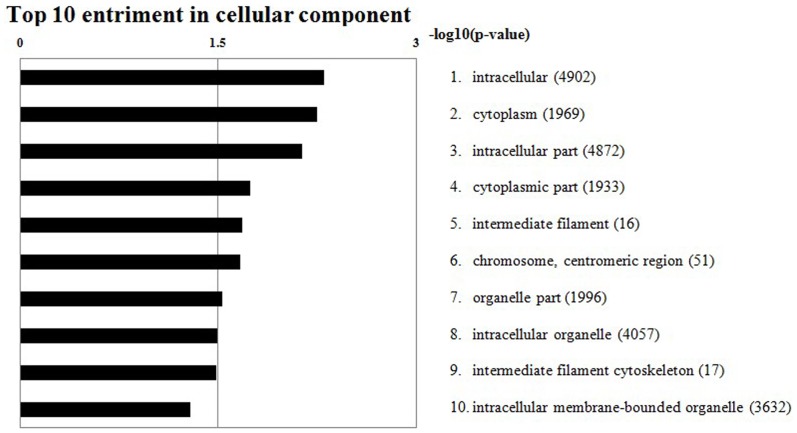
Top 10 enrichment cellular components.The numbers of genes involved in the components are indicated in parentheses.